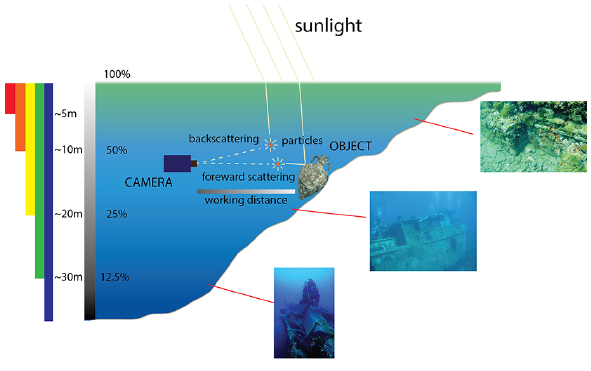
Figure 1: Schematic representation of underwater lighting conditions that can cause color